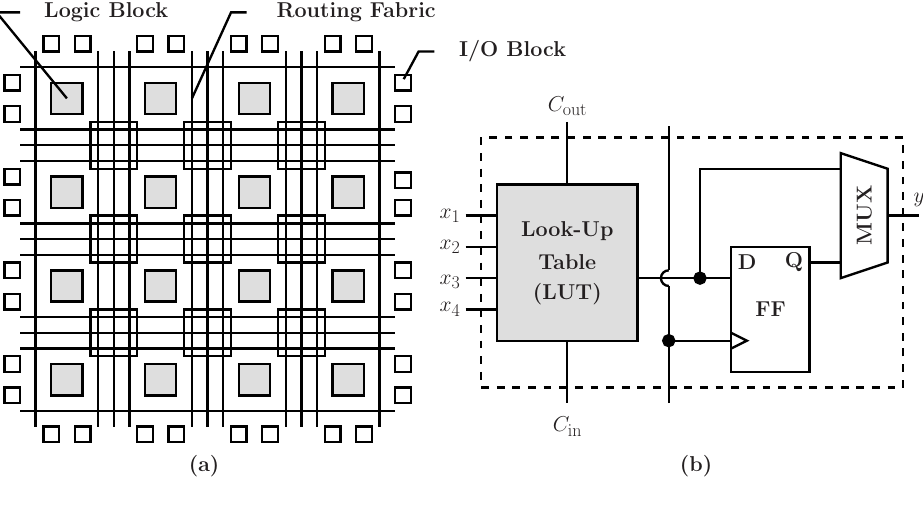
Figure 7. ( a ) Sketch of the FPGA architecture; ( b ) diagram of a simple logic block. FF,